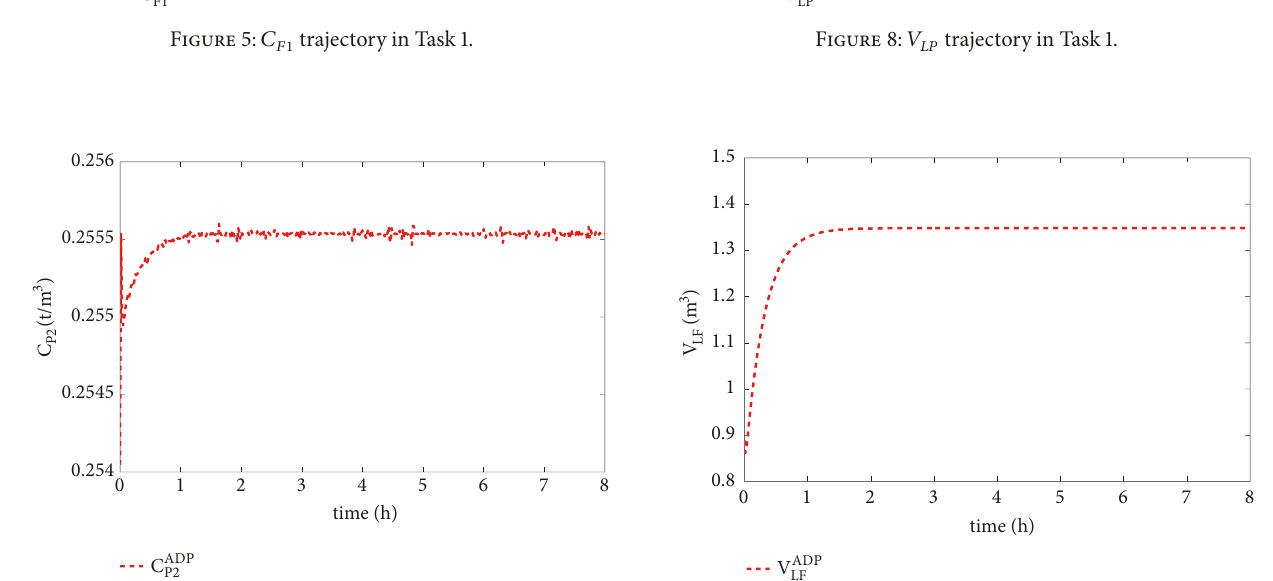
Figure 8: 𝑉 𝐿𝑃 trajectory in Task 1.